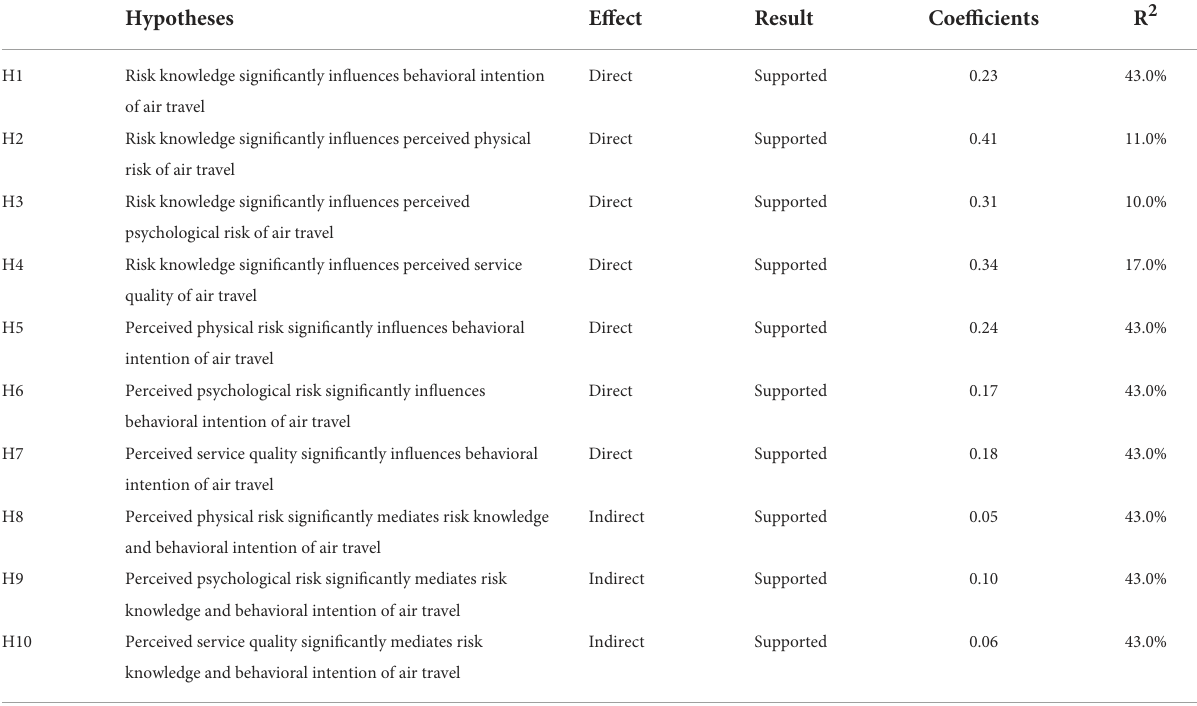
TABLE 8 Summary hypothesis testing analysis of risk knowledge pathways to behavioral intention of air travel risk perception during